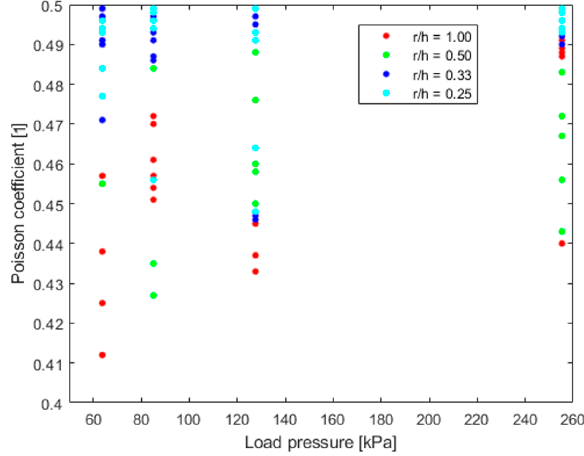
Figure 17. Poisson ratio obtained from z lowest RMSE curve fitting for each load and sample.